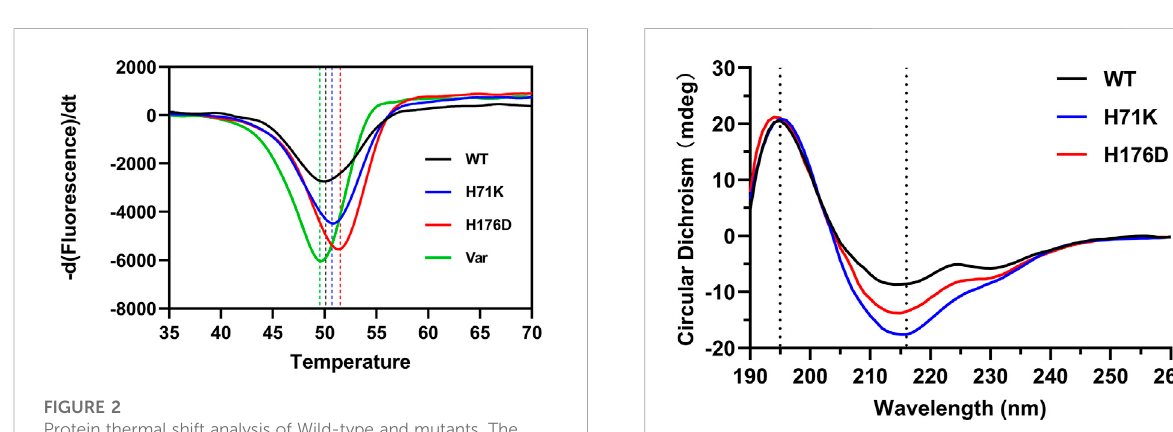
FIGURE 3 CDcharacterizationoftheWTandmutantsbetween190and 260 nm.Thedottedlineindicatesthepositionofthecharacteristic peaks (195 and 216 nm) of β